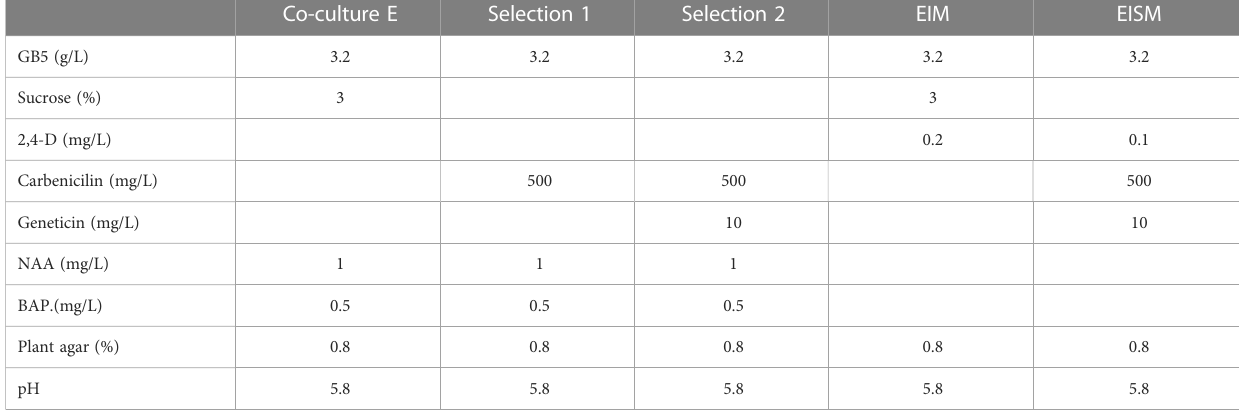
TABLE 2 Composition of the plant in vitro culture media used for transformation protocol E and for induction of somatic